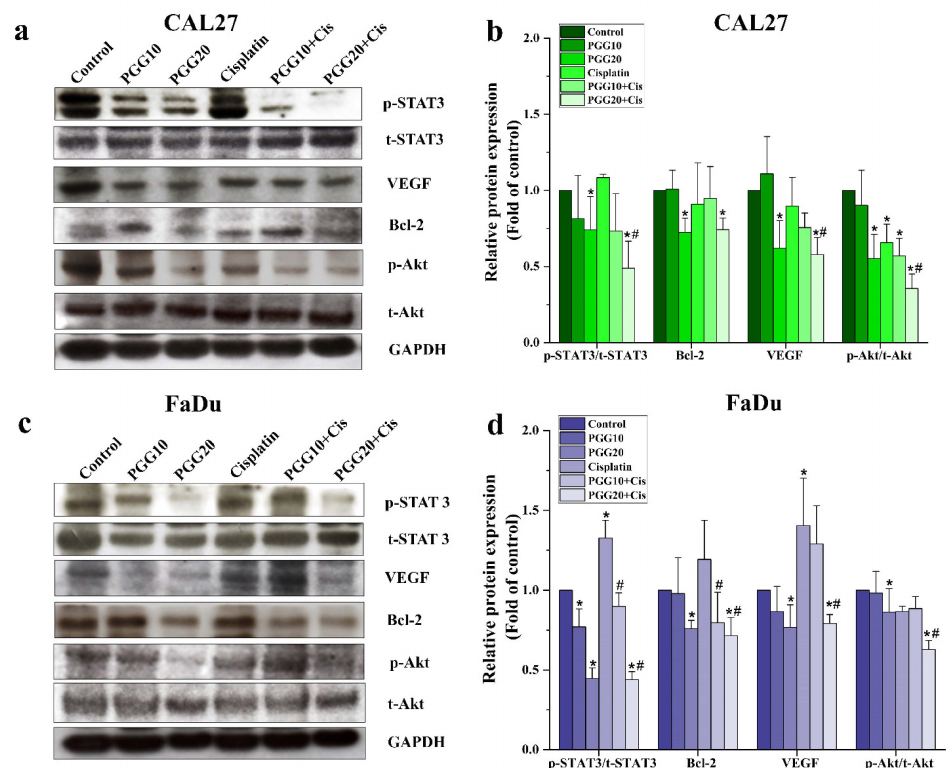
Figure 5. The effect of PGG and cisplatin alone or in combination on STAT3/Akt signaling proteins in HNSCC cancer cells. Representative images from Western blot analysis of the expression of p-STAT3, total STAT3 and p-AKT, total Akt, Bcl-2, VEGF and GAPDH following treatment with either PGG (10, 20 µ g/mL) or cisplatin (2 µ g/mL) alone, or their combination for 48 h in CAL27 cells ( a ) and FaDu cells ( c )(uncropped images are provided in the Supplementary Figures S6 and S7). The bar diagram showing the fold change of protein expressions. The relative density values of related proteins were quantified, and their protein levels were normalized to the loading control GAPDH ( b , d ). All data are expressed as the mean ± SD of three independent experiments. * p < 0.05: significantly different from the control, and # p < 0.05: significantly different from cisplatin treatment alone. PGG, pentagalloyl glucose; Cis, cisplatin; Akt, serine/threonine kinase; STAT3, signal transducer and activator of transcription 3; p, phosphorylated; t, total; GAPDH, glyceraldehyde 3-phosphate dehydrogenase; VEGF, vascular endothelial growth